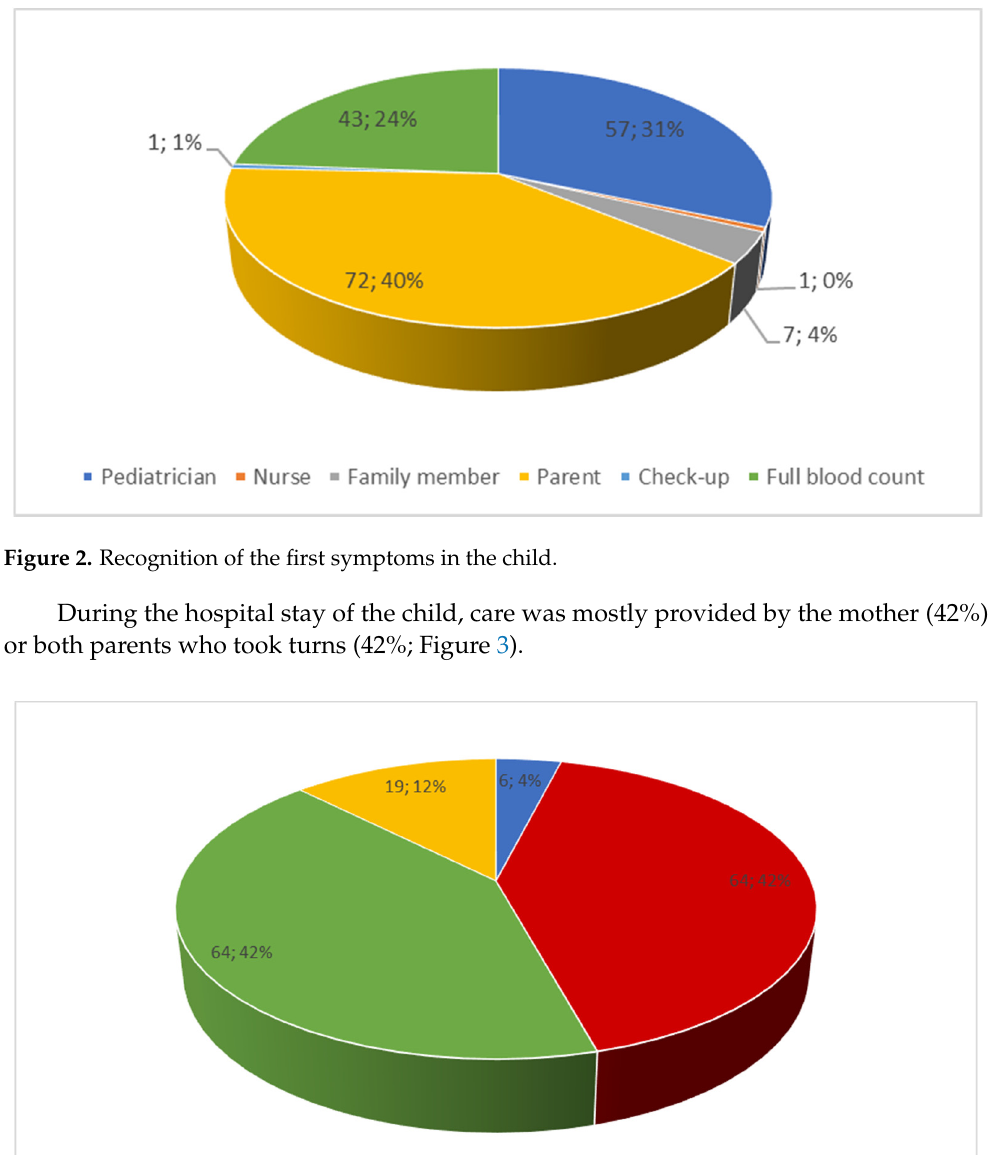
Figure 1. Diagnoses in children with cancer.